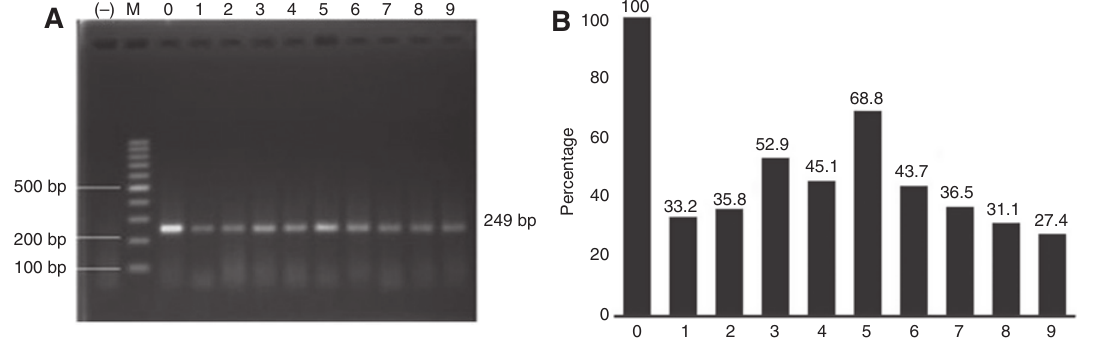
-anti-TB complex stability. (–); M; negative control, 100-bp marker. 1, … , 63: Complexes used in the experiment with- Figure 3: (A) NP-NH 2 drawn at the indicated time points from 1 to 63 days. (B) ImageJ analysis of the intensity of DNA band in lanes 1, … , 63 in (A), respectively.